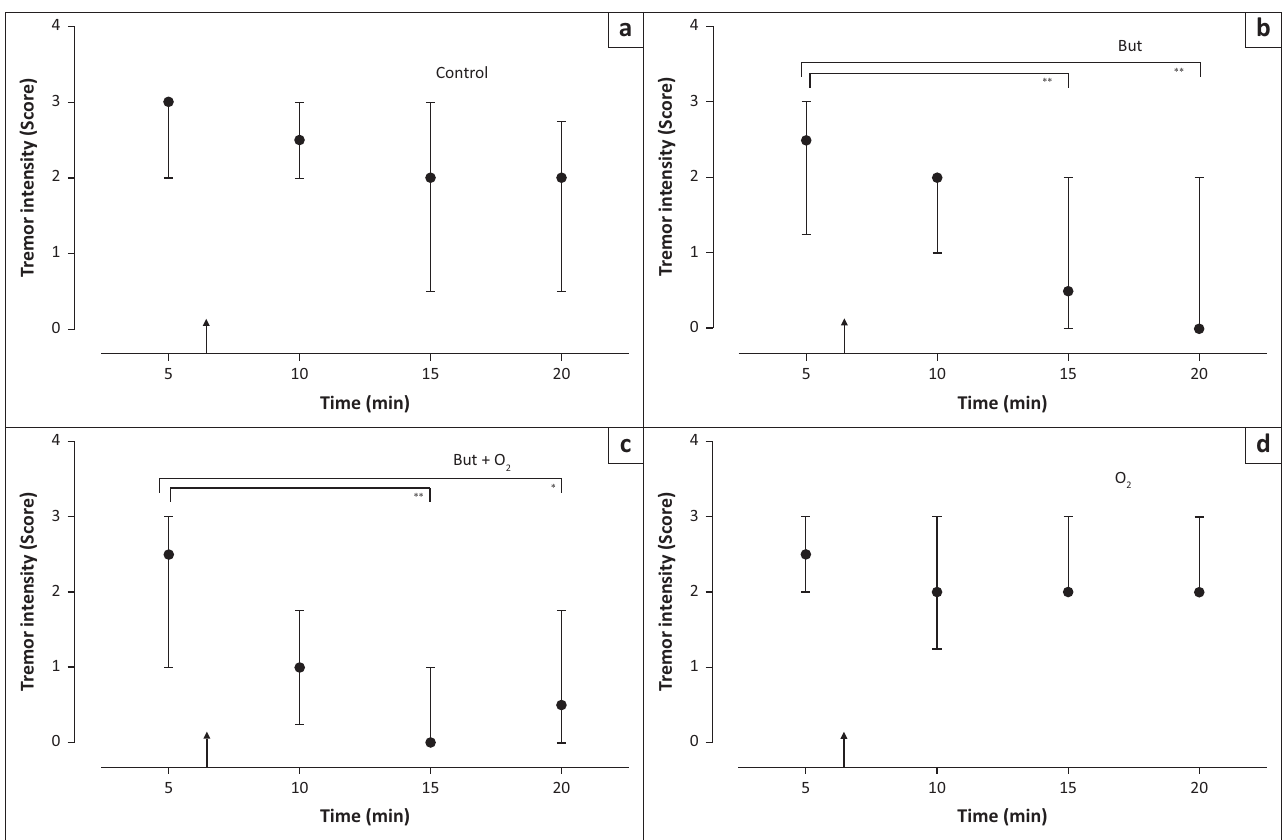
FIGURE 3: The median observed tremor intensity score with interquartile ranges for eight boma-held rhinoceros chemically immobilised with a mixture of etorphine and azaperone. Six minutes after they were placed into lateral recumbency, each rhinoceros received one of four interventions (arrow), on four separate occasions. The interventions included sterile water (IV) (control) (a), butorphanol (IV) only (b), the combination of butorphanol (IV) and nasotracheal oxygen insufflation (c), or nasotracheal oxygen insufflation only (d). Brackets indicate significant differences in tremor intensities compared to pre-intervention administration at 5 min ( * , p < 0.05; ** , p < 0.01; Friedman’s and post-hoc Dunn’s